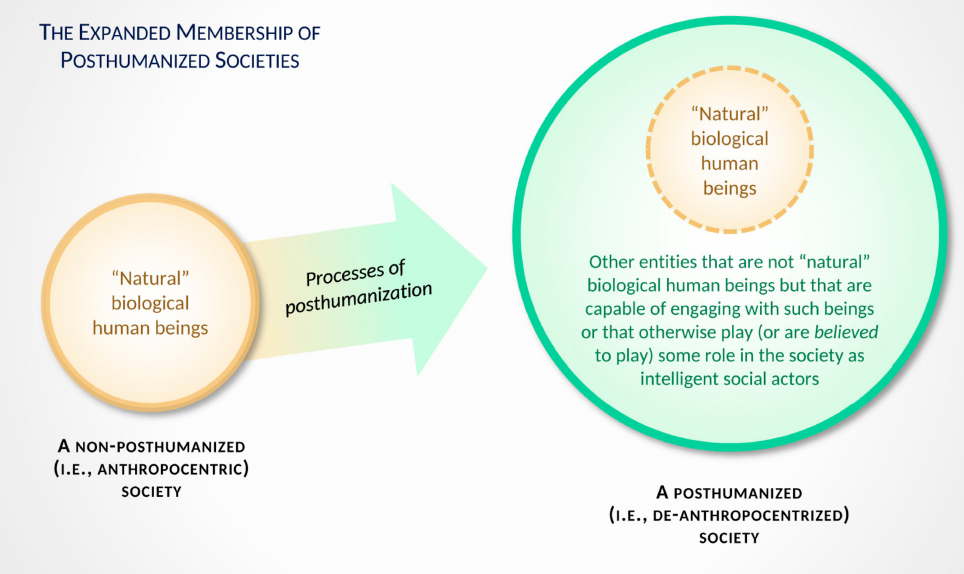
Figure 1. A society that has become “posthumanized” no longer has natural biological human beings as its sole members and